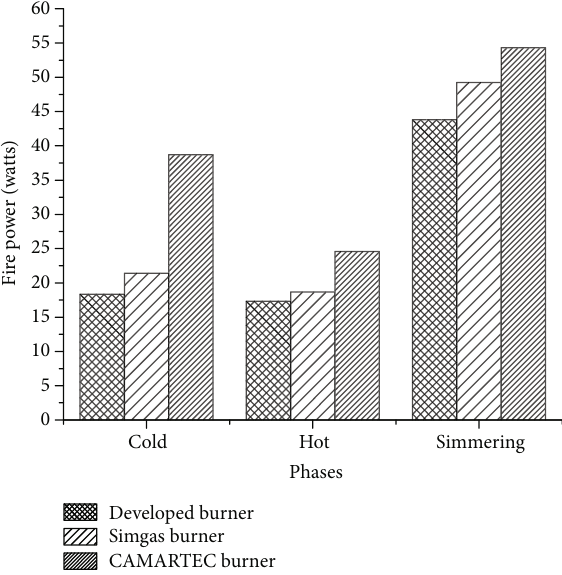
Figure 13: Firepower during cold, hot, and simmering phases of the developed burner and the Simgas and CAMARTEC